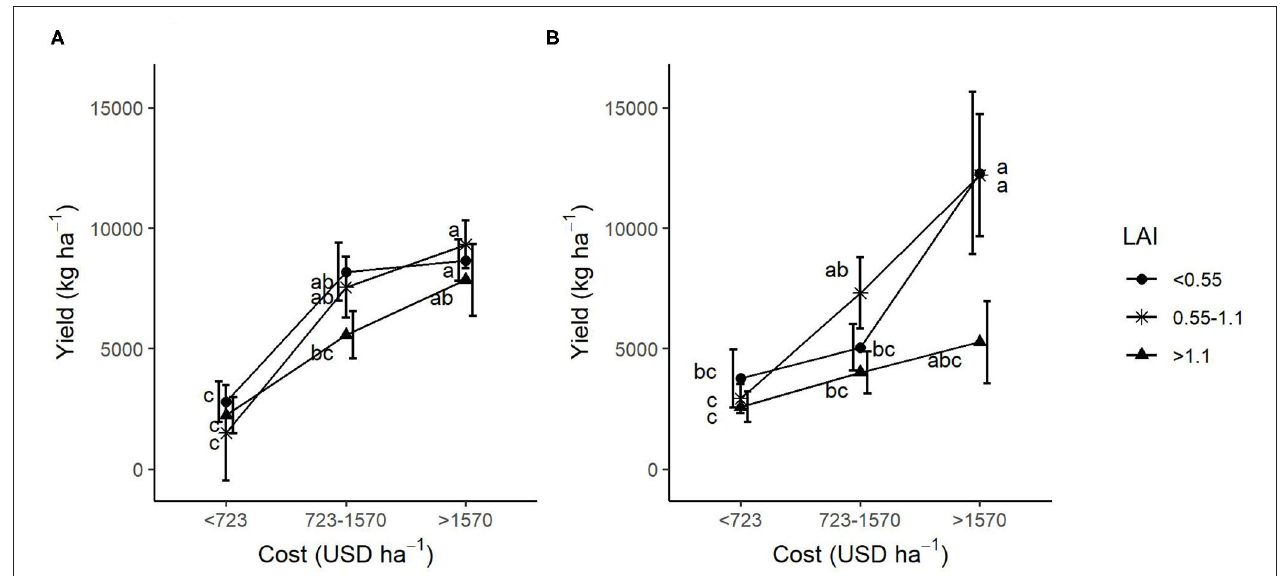
FIGURE 4 | Coffee production for different levels of agronomic investment (cost) and shade LAI for (A) Costa Rica and (B) Guatemalan plantations. Means with a common letter are not significantly different ( p > 0.05).